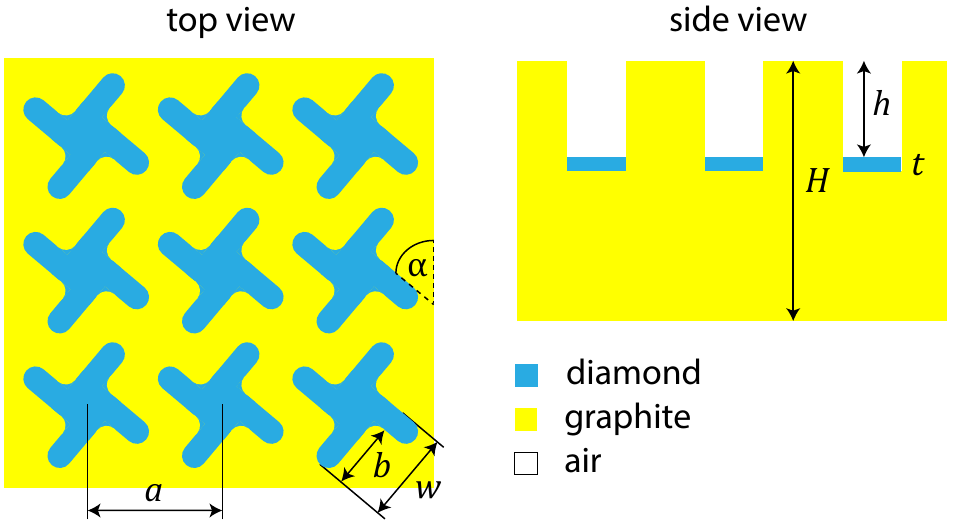
Figure 8. Schematic of a model structure. In the calculation, the following parameters are used: a = 11.5 µ m, w = 8.1 µ m, b = 5.6 µ m, α = 50 ◦ , H = 9 µ m, h = 2.5 µ m, t =